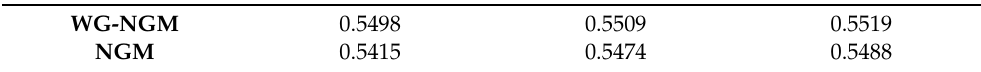
Table 2. Final results of SSIM.